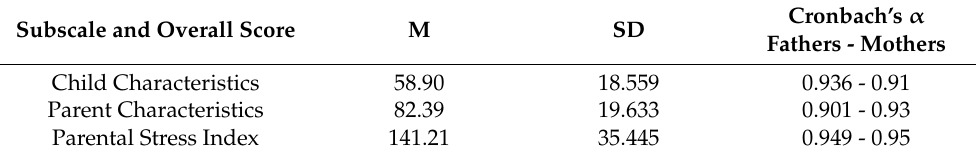
Table 4. Characteristics of the overall score and the subscales of the EBI in